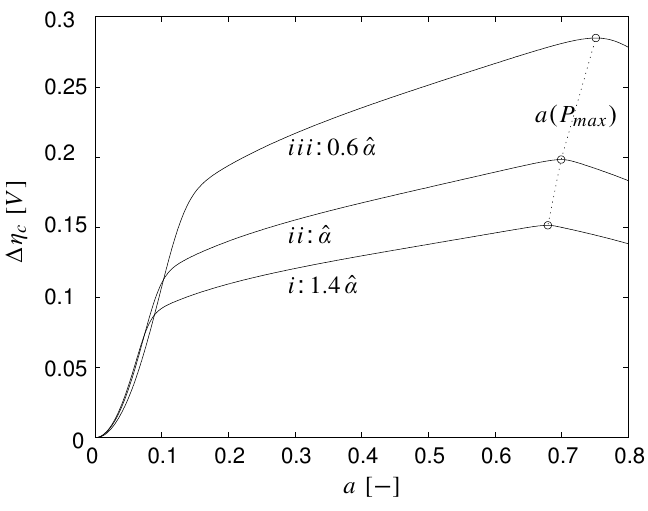
of the overpotential with respect to the c ) denotes max max